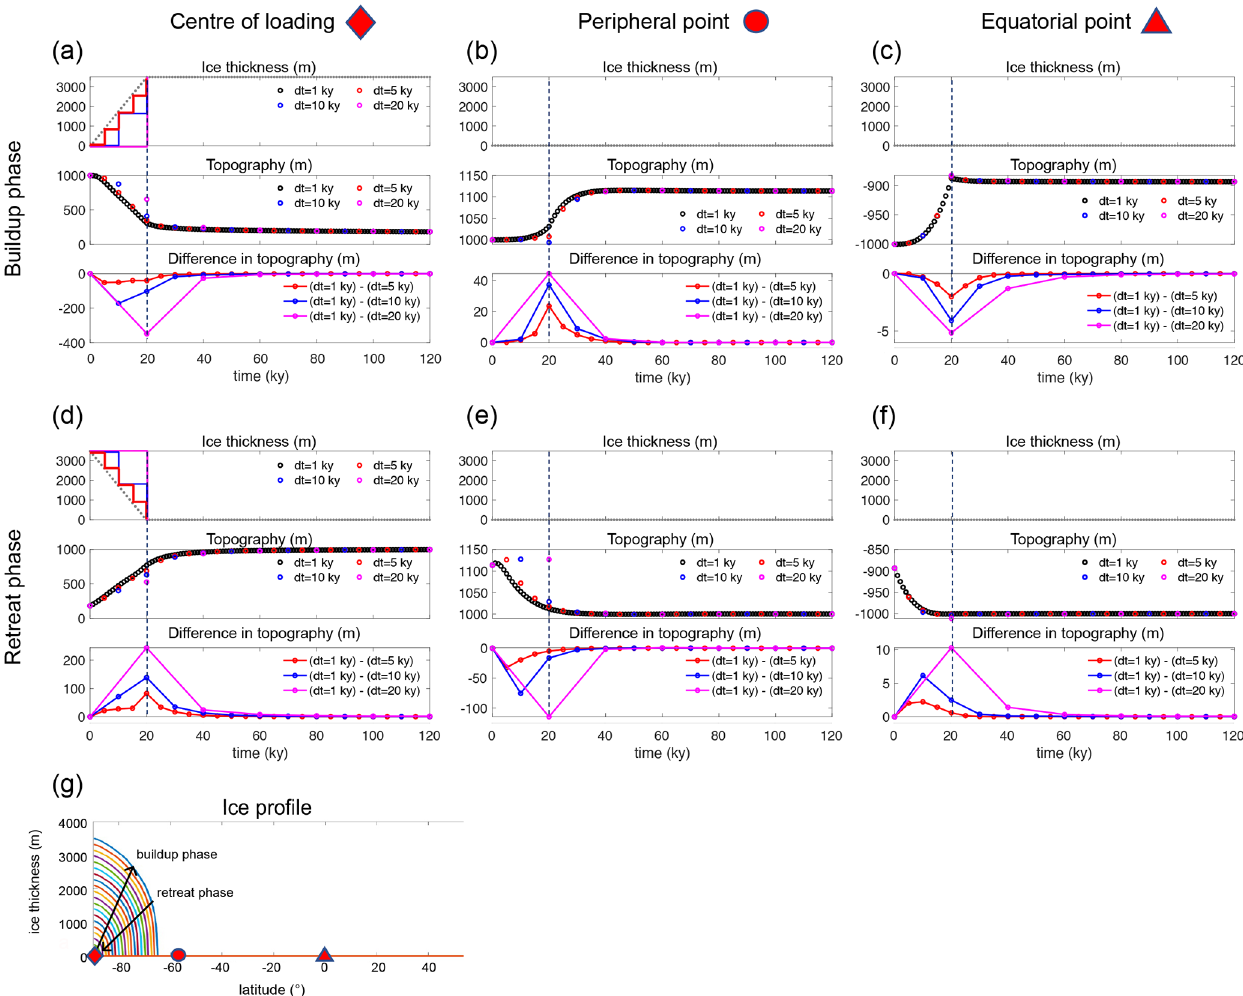
Figure 2. The sensitivity of predicted topography (sea level) changes to the temporal resolution ( dt ) of the sea-level model and ice profile adopted in this experiment. (a–f) Results of idealized simulations in which input ice history evolves at a uniform rate in an axis-symmetric dome shape during a build-up phase (a–c) and a retreat phase (d–f) at the centre of loading (first column), peripheral point (second column) and far-field equatorial point (third column). In each panel, the top frame shows ice thickness in meters, the middle frame shows the elevation of topography in meters from simulations that incorporate the uniform time stepping of dt = 1kyr (black dots), 5kyr (red dots), 10kyr (blue dots) and 20kyr (magenta dots), and the bottom frame shows differences in predicted topography from the simulation with the benchmark resolution (black dots in the middle panel, dt = 1kyr) and coarser temporal resolution (red, blue and magenta dots in the middle panel). Dashed vertical lines at 20kyr mark the timing at which the ice stops loading. The staircase-like solid lines in (a) and (d) represent the step function of ice loading change in respective simulations. (g) Schematic of the half-cross section of the ice profile incorporated in the idealized simulations in the Southern